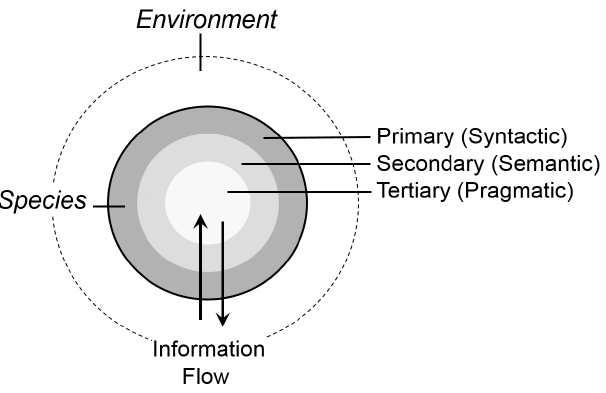
Fig. 4 . General reference model of information structure and flow in evolutionary, adaptive systems, e.g., a species and its